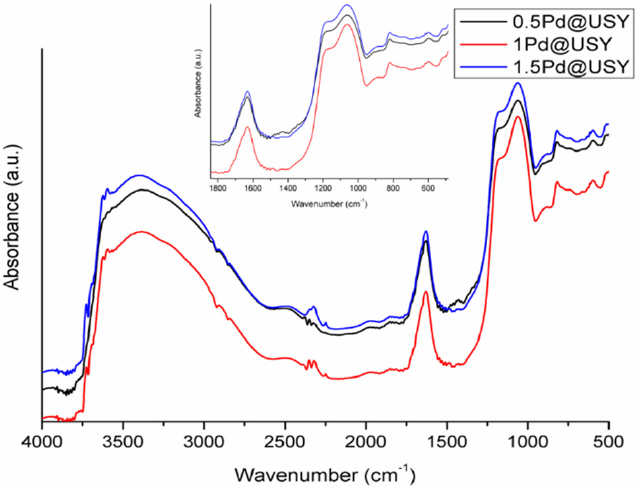
Figure 11. DRIFT spectra of the 0.5Pd@USY, 1Pd@USY, and 1.5Pd@USY and an inset in the 1800–500 cm − 1 range.